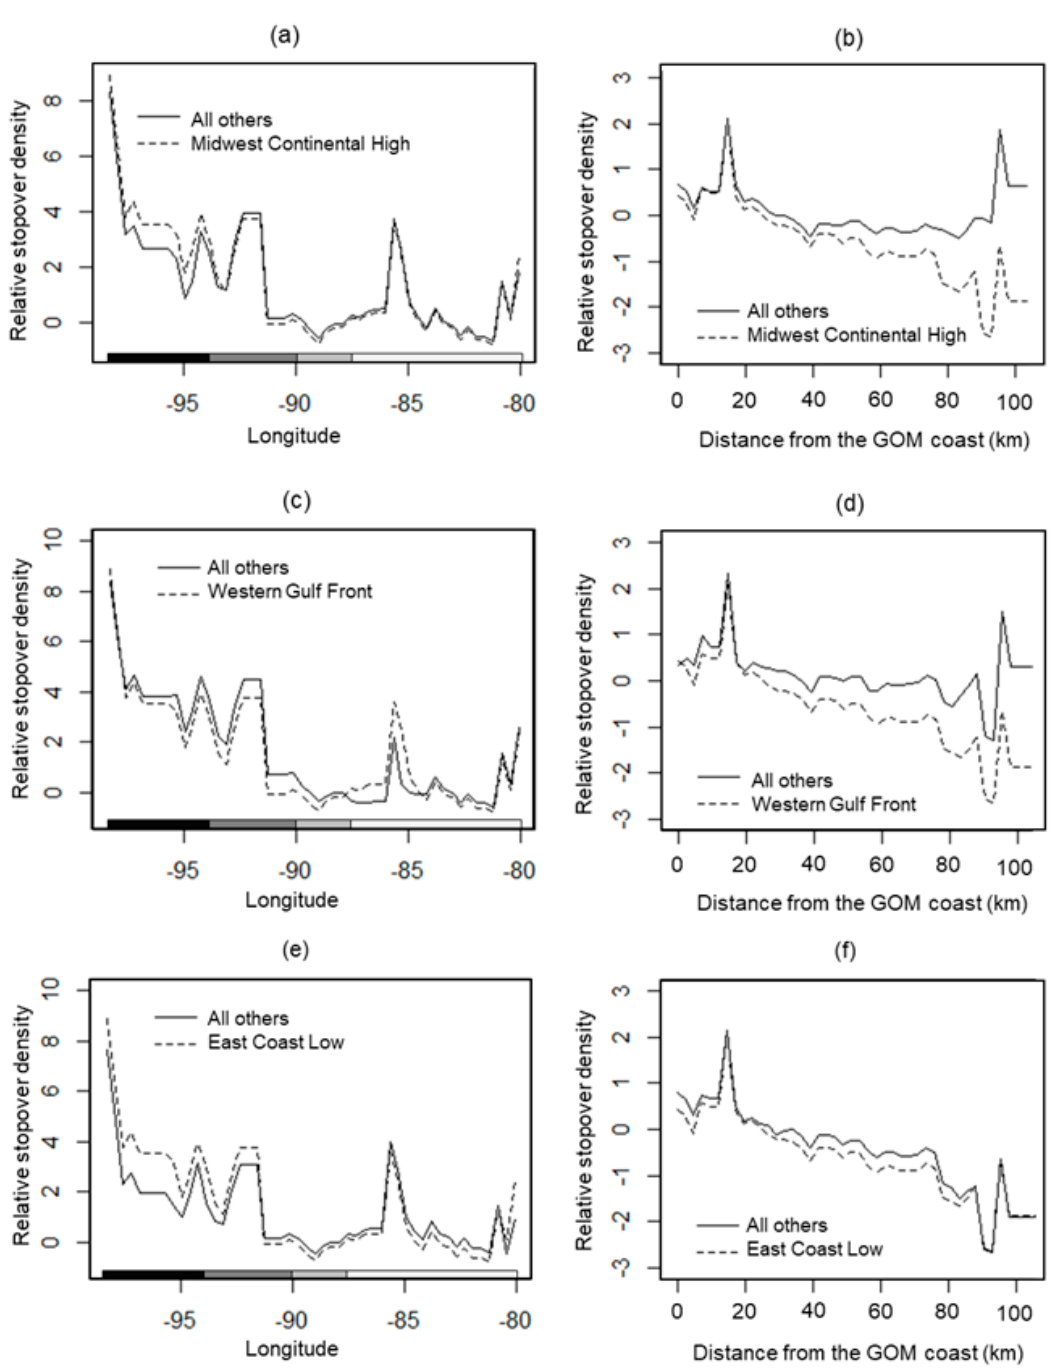
Figure 5. Plots of interactions among longitude ( a , c , e ) and distance from the Gulf of Mexico (GOM) coast ( b , d , f ) and the three most influential en route synoptic weather types ( a , b : Midwest Continental High; c , d : Western Gulf Front; e , f : East Coast Low) from a boosted regression tree model predicting mean bird stopover density within the northern GOM coastal region. The solid line represents the combined response of all the other synoptic weather types. The shaded bars underneath the longitude interactions indicate the state, with Texas on the far left, followed by Louisiana, Mississippi / Alabama, and Florida.